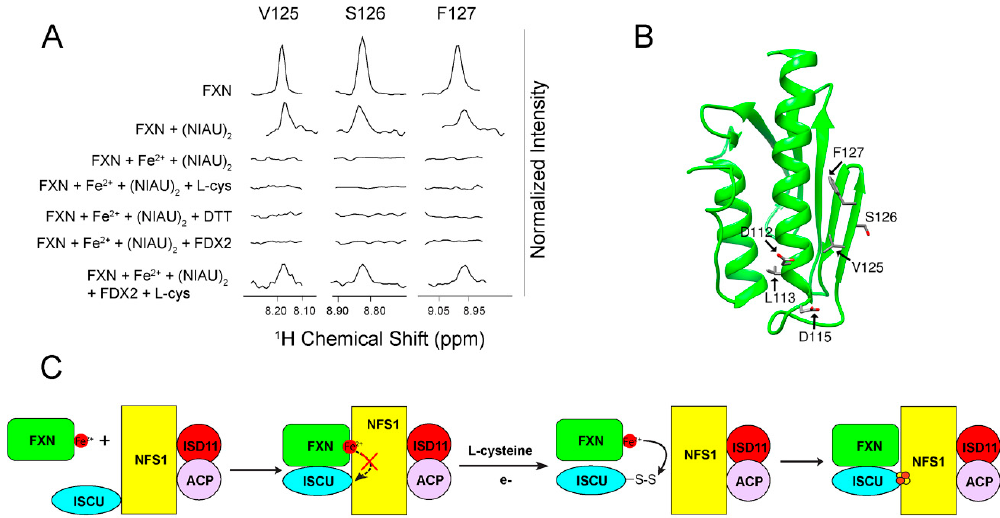
Figure 5. Results showing that Fe 2+ bound to FXN remains bound when FXN interacts with (NIA) 2 but becomes labile upon the addition of both L -cysteine and FDX2. ( A ) One-dimensional sections along the 1 H-dimension from two-dimensional 1 H- 15 N TROSY-HSQC peaks assigned to residues V125, S126 and F127 under conditions specified in the figure; ( B ) Structure of FXN (PDB: 1EKG) indicating the positions of the residues studied; ( C ) Schematic representation of the possible mechanism by which FXN controls iron entry into ISCU. Adapted from Ref. [156] with permission.